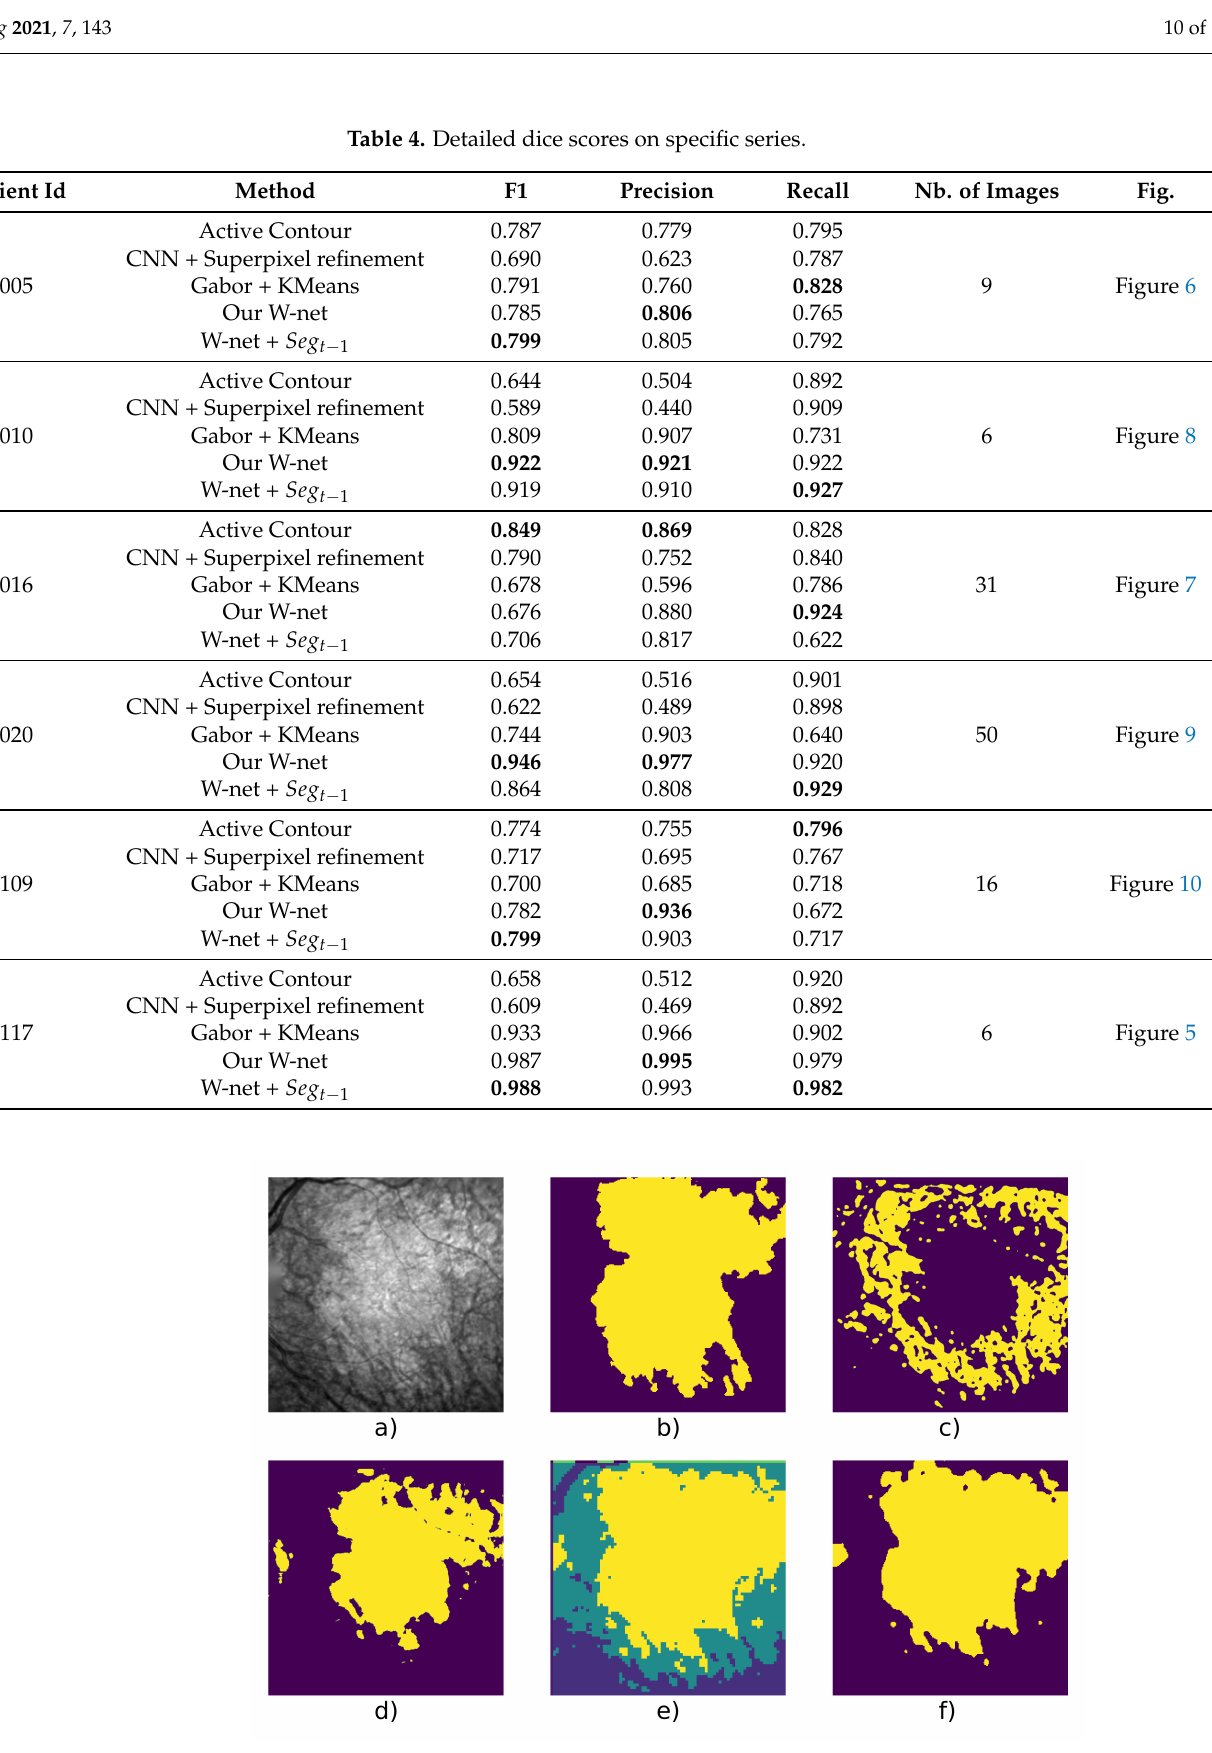
Figure 6. Patient id 005: ( a ) original image, ( b ) ground truth, ( c ) Gabor method segmentation, ( d ) W- net segmentation, ( e ) CNN + superpixel refinement segmentation, ( f ) active contour